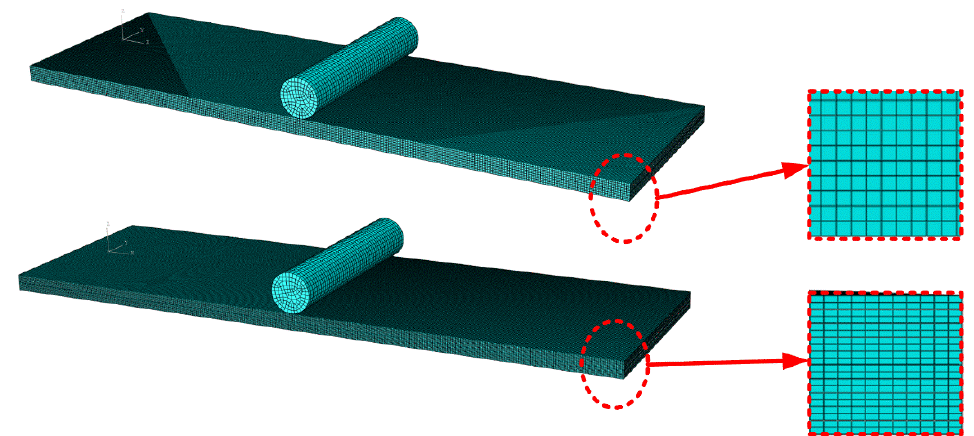
Figure 11. Finite element model of GFRP laminates.